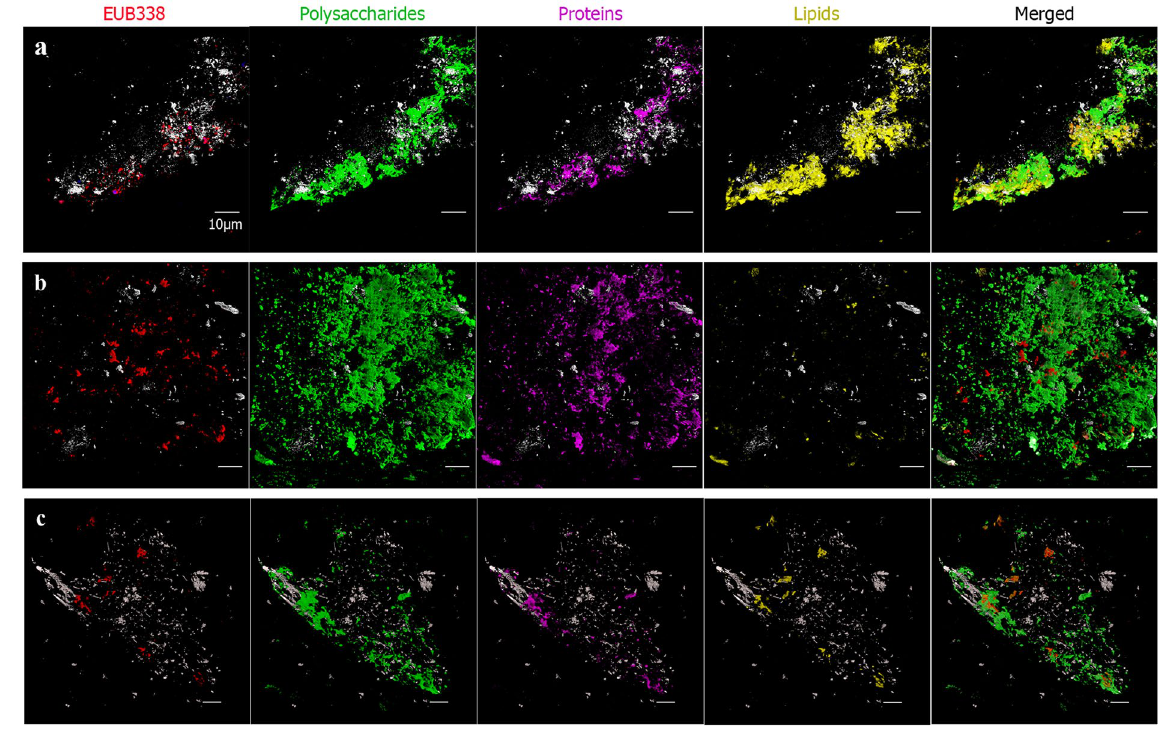
Figure 4. Bacterial biofilm detection in subsurface hard rock samples from different depths. DOPE-FISH of bacteria (red), FITC-ConA (green), SYPRO ruby (violet) and Nile red (yellow) at 355,7 mbs ( a ), 420 mbs ( b ) and 519, 1 mbs ( c ). Scale bar 10 μ